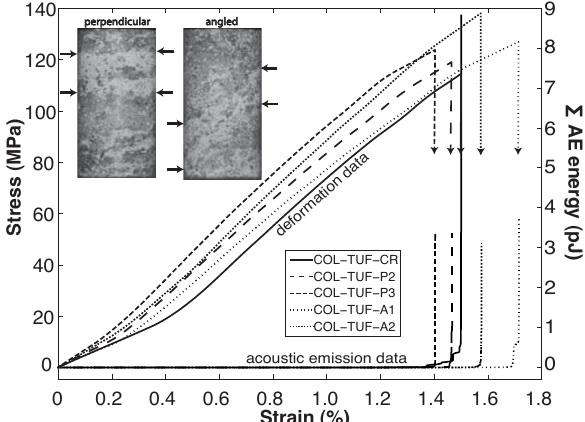
Fig. 4. Plots of stress vs. strain and cumulative AE energy ( 6 AE) against strain for constant loading experiments on andesite free of tuffisite (COL-TUF-CR), with tuffisite at 45 ◦ (COL-TUF-A1 and -A2) and perpendicular (COL-TUF-P2 and -P3) to sigma 1. The UCS for all samples are constant within 17% of the maximum UCS. Inserts show examples of core samples with tuffisites at 45 degrees and perpendicular to compression. Arrows indicate the top and bot- tom boundaries of tuffisite